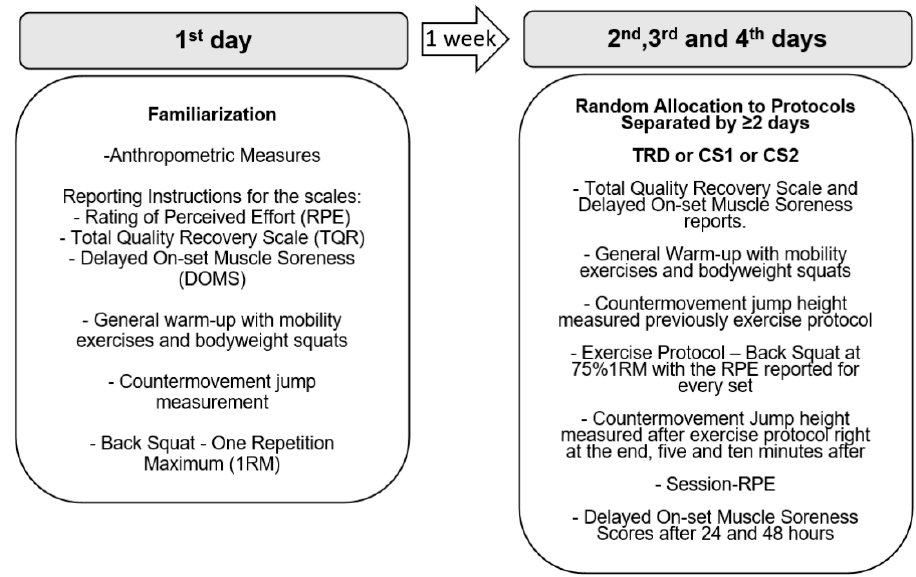
Figure 1. Summary of the study. 1st day refers to the familiarization session while 2nd, 3rd, and 4th days refers to the experimental sessions. Traditional (TRD), Cluster 1 (CS1), and Cluster 2 (CS2) set configurations for the back squat exercise.